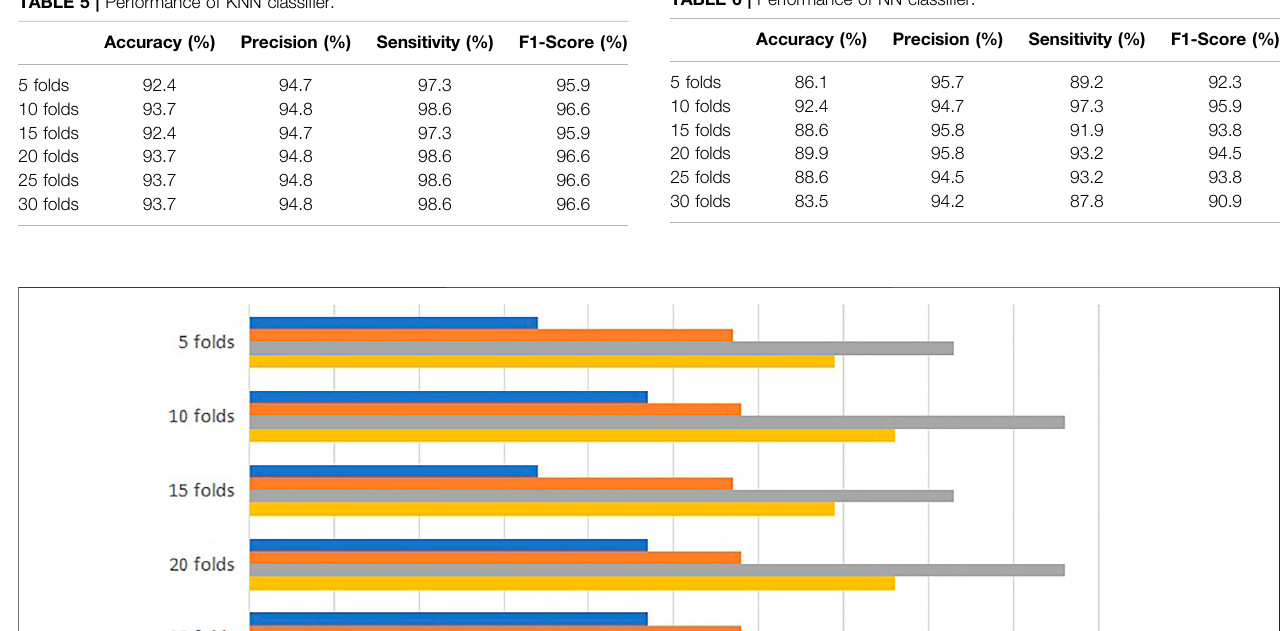
TABLE 6 | Performance of NN classi fi